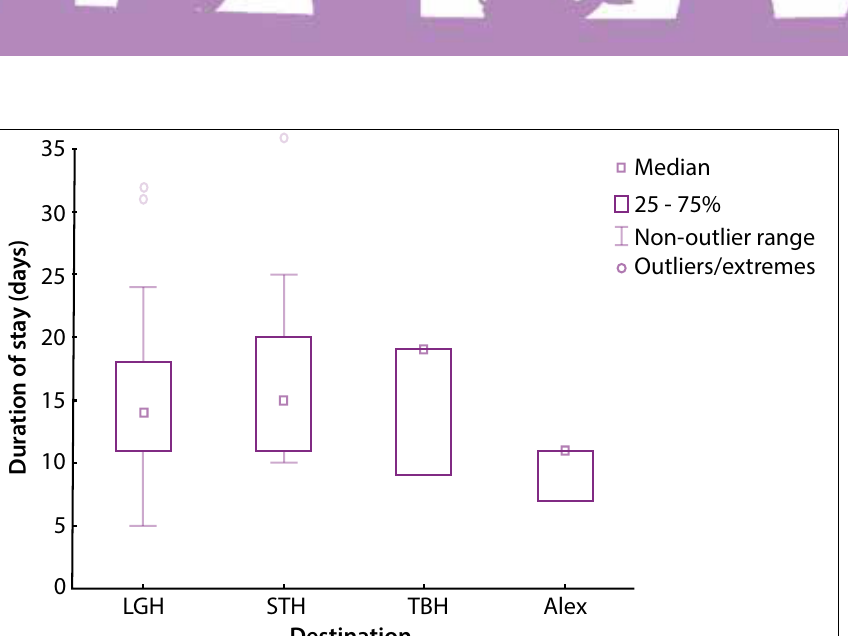
Fig. 1. Box and whisker plot showing duration of stay at the specialist psychiatric hospitals. (LGH = Lentegeur Hospital; STH = Stikland Hospital; TBH = Tygerberg Hospital; Alex =